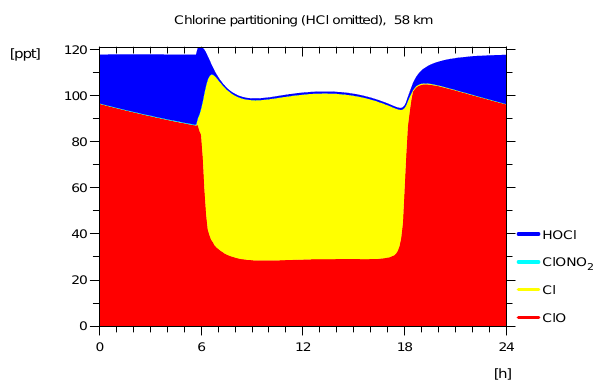
Fig. 1. Diurnal variation of the chlorine partitioning (HCl omitted) at 0.28hPa altitude according to model calculations for 30 ◦ S, 31 March. + [HO 2 ] by photolysis, and reactions involving O( 1 D) stop after sunset; HO x is converted to reservoir species by several reactions, e.g. OH + NO 2 + M → HNO 3 + M). 3. Nighttime conditions in the mesosphere are suitable for the